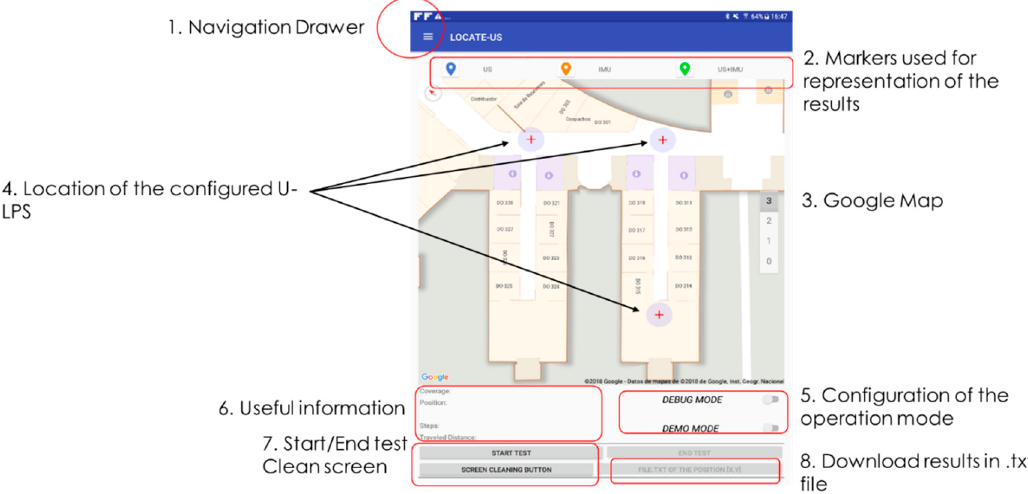
Figure 17. Main Screen in LOCATE-US application.